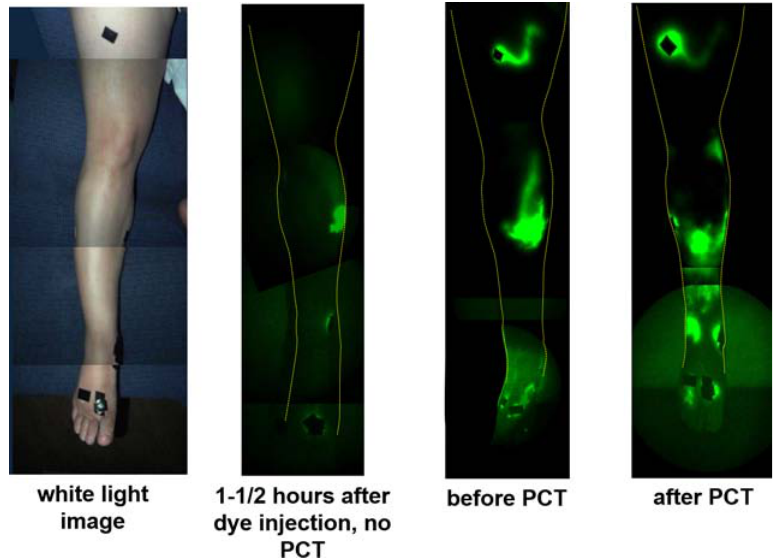
Fig. 3. Fluorescent dye/lymph distribution in right anterior leg before and after PCT in subject 1. (leftmost) White light image, (second from left) NIRFLI image 1 – 1/2 – 2 h after dye injection, from ¯rst imaging session, in which no PCT was performed (18 months prior to second imaging session), (third from left) NIRFLI image before PCT in second imaging session, (rightmost) NIRFLI image after PCT in second session (1 – 1/2 – 2 h after dye injection).